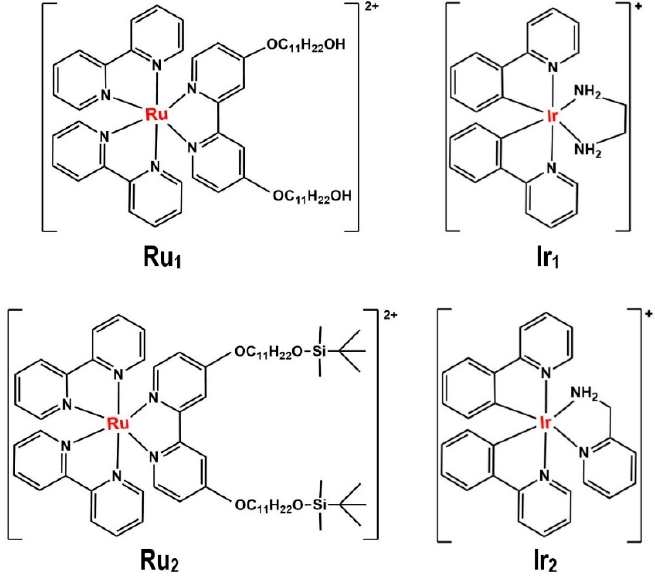
Figure 7. Chemical structures of Ru 1 , Ru 2 , Ir 1 , and Ir 2 complexes used by Ricciardi et al. [86], redrawn by the authors from the reference.